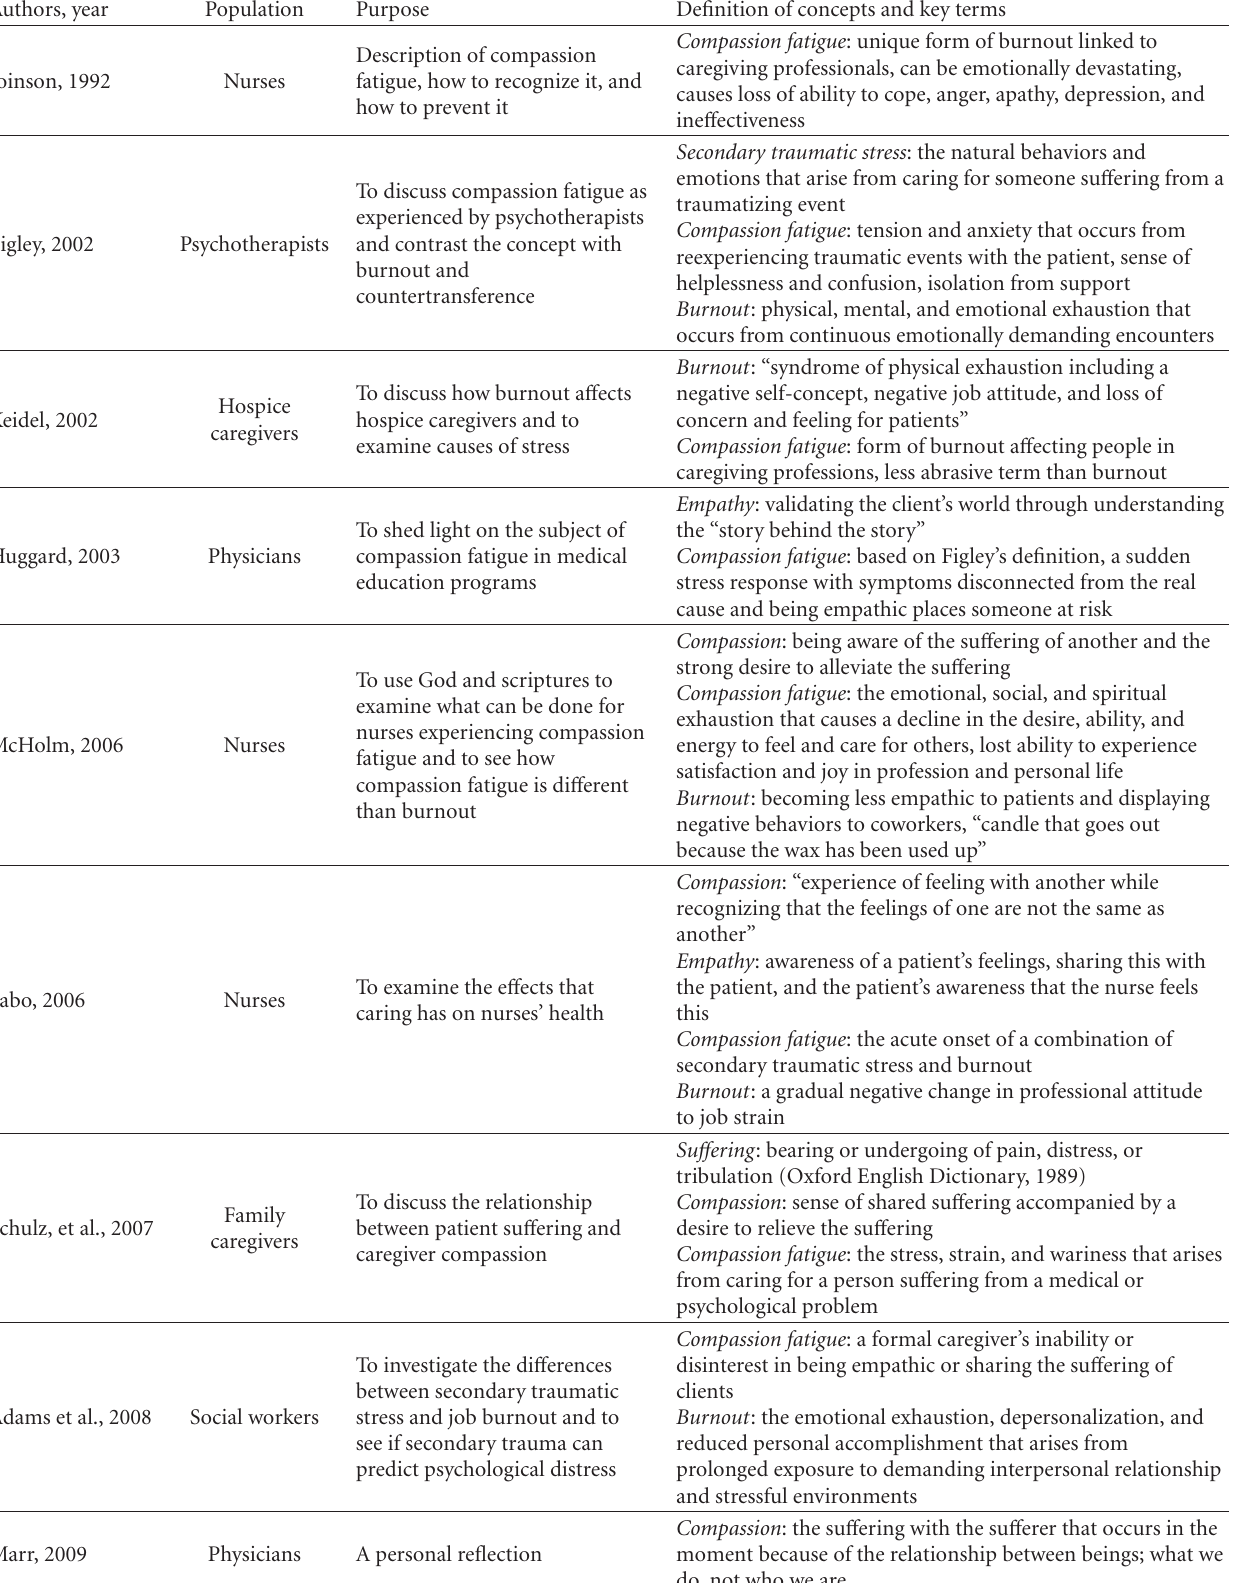
Table 1: Definitions of concepts and key